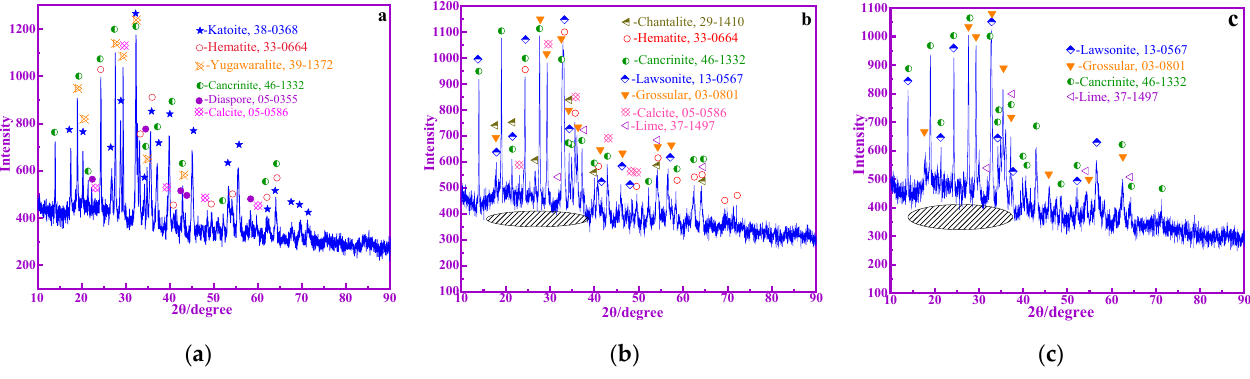
sorbed water has been removed during the drying process as the BRM was dried at 100 °C before the experiment, only 0.26% of the physically adsorbed water is removed within the range of 30 °C to 105 °C. The weight loss rate is 7.92% in the range of 105–500 °C, which is mainly the removal of chemically bound water. The second stage is located in the tem- perature range of 500 to 770 °C, and the weight loss rate is 4.86%, which is mainly caused by the decomposition of aluminosilicate-carbonate in the BRM to release CO 2 .